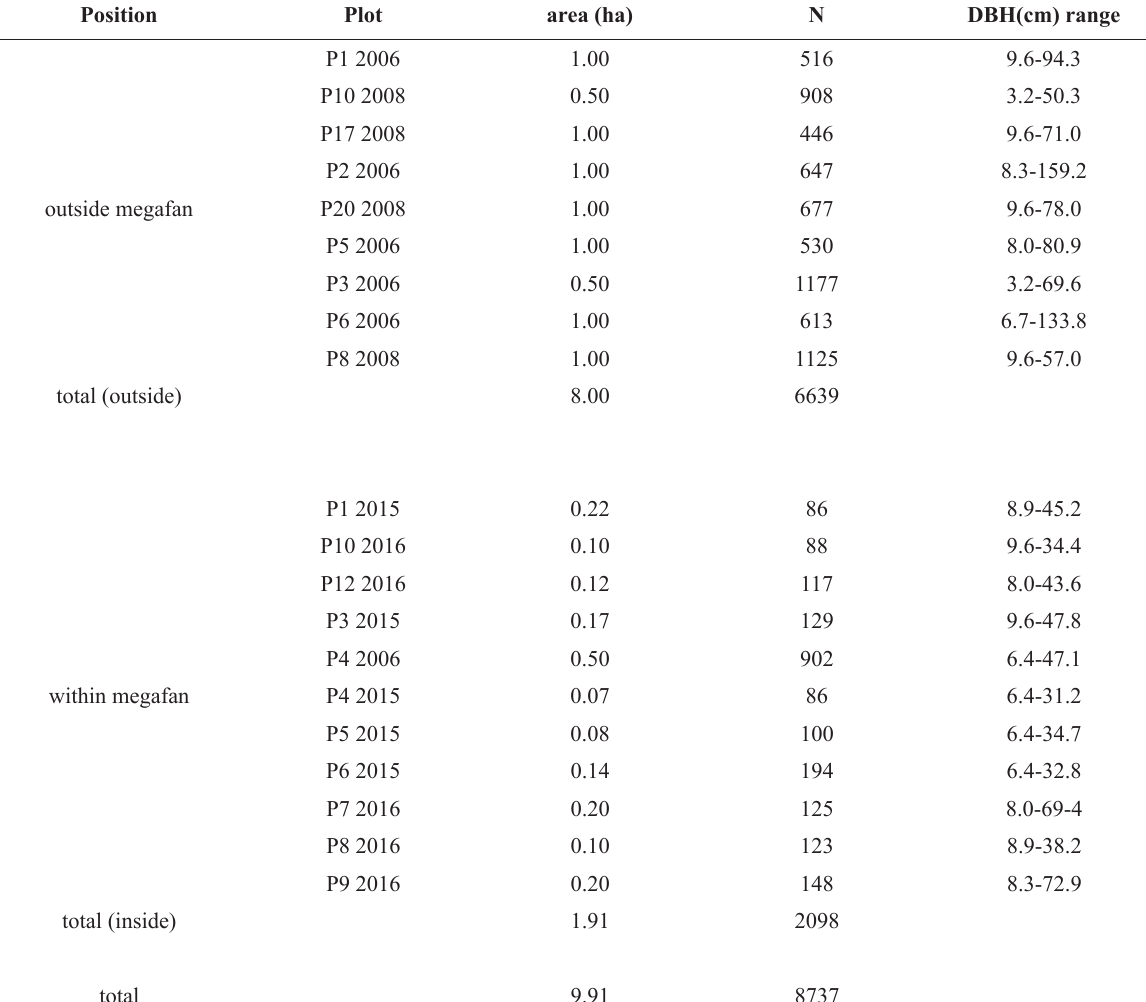
Characteristics of the tree plots inventoried in the Viruá megafan area (N=number of individuals). Position Plot area (ha)